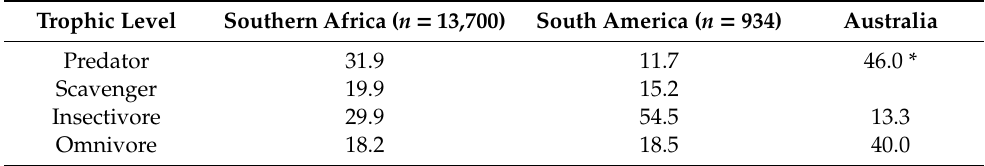
Table 1. Road count data shown as percentages of trophic categories; data extracted from [103,109] and unpublished data collected by W.R.J. Dean. Pied Crows and White-necked Ravens have been included in this table as 50% omnivores, 50%